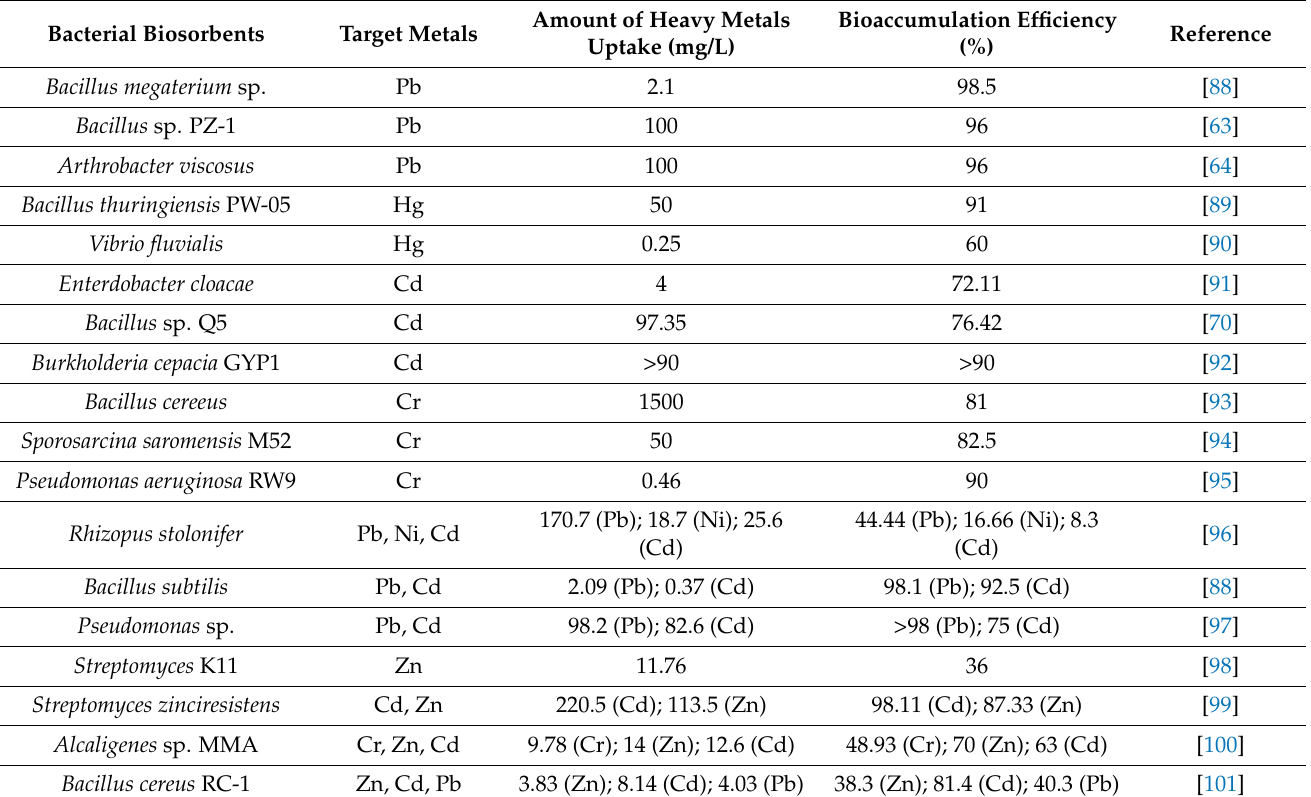
Table 3. The potential bacterial strains that can remove HMs via bioaccumulation